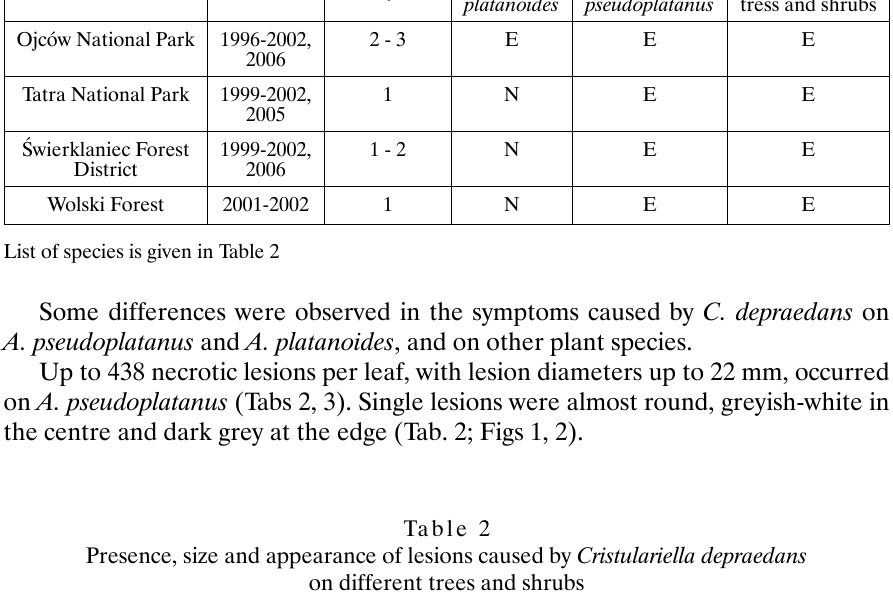
Presence, size and appearance of lesions caused by Cristulariella